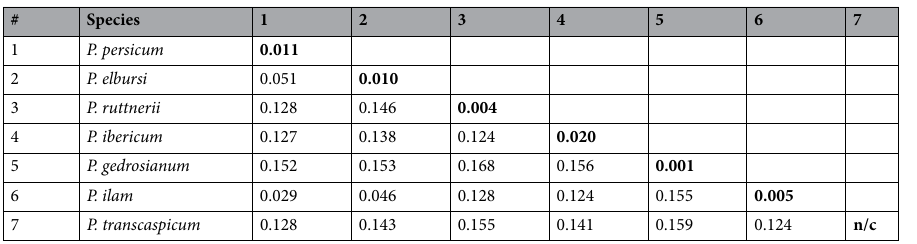
Table 2. Estimates of average evolutionary divergence over sequence pairs between and within groups. The number of base differences per site from averaging over all sequence pairs within each group is shown in the diagonal and is marked in bold. “n/c” is shown in one case because only one sequence was available for